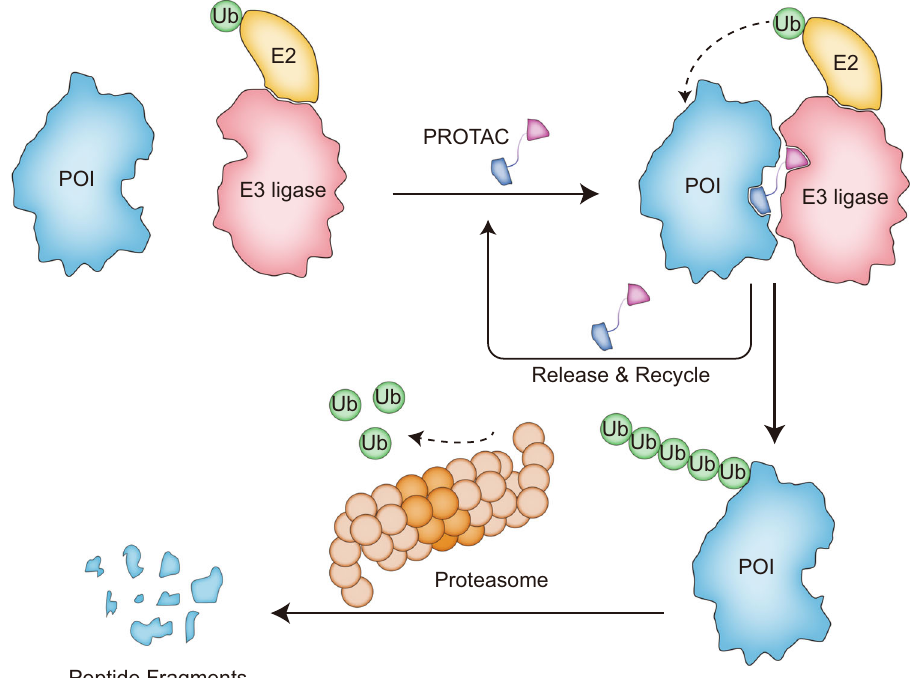
Fig.1 |ThedegradationmechanismofPOI (ProteinofInterest)byPROTACs. ThePOIand E3ligasearebroughttogetherbyPROTACs,whichfacilitatesthetransferof ubquitin. The POI labeled with ubquitin is recognized by proteasome and degraded into